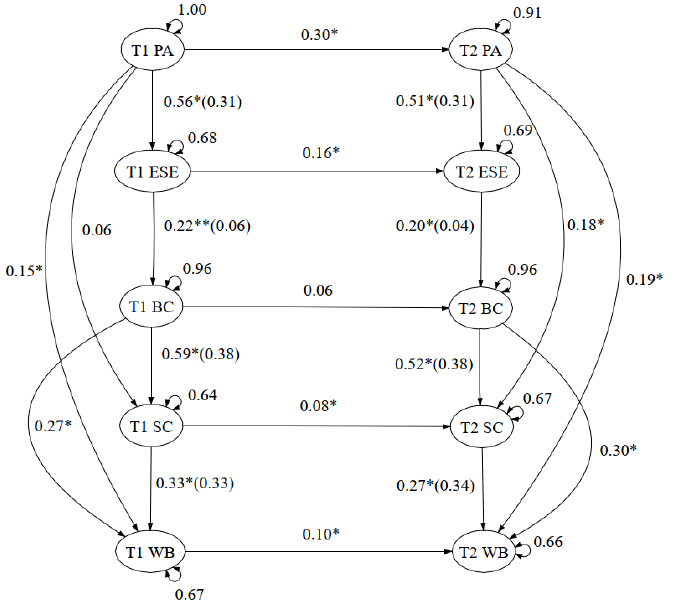
Figure 2. Exercise and Self-esteem Model Revised With Self-Compassion Including Mental Well- being—Panel Analysis Framework. Note. Standardized coefficients, total variance explained on the outcome ( R 2 ) and errors are presented. R 2 is presented in brackets, in the form of β ( R 2 ). * p < 0.05, ** p < 0.01. T1 PA = Time 1 physical activity; T2 PA = Time 2 physical activity; T1 ESE = Time 1 exercise self-efficacy; T2 ESE = Time 2 exercise self-efficacy; T1 BC = Time 1 body compassion; T2 BC = Time 2 body compassion; T1 SC = Time 1 self-compassion; T2 SC = Time 2 self-compassion; T1 WB = Time 1 mental well-being; T2 WB = Time 2 mental well-being.